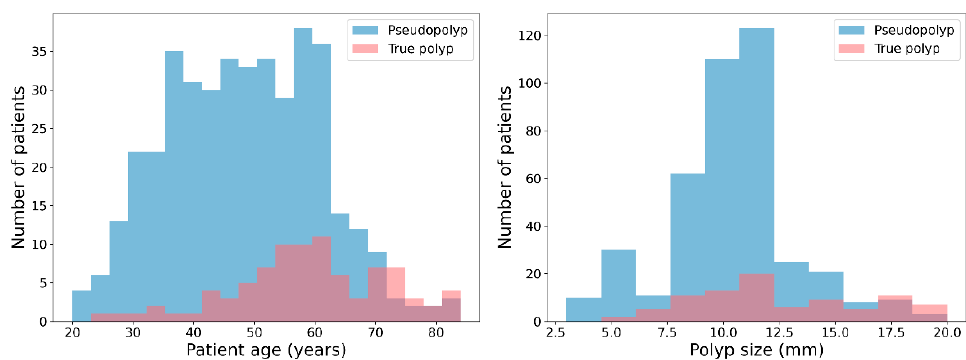
Figure 4. Histograms of patients with pseudopolyp and true polyp by age and polyp size. The distributions of pseudopolyps and true polyps are illustrated by blue and red bars, respectively.